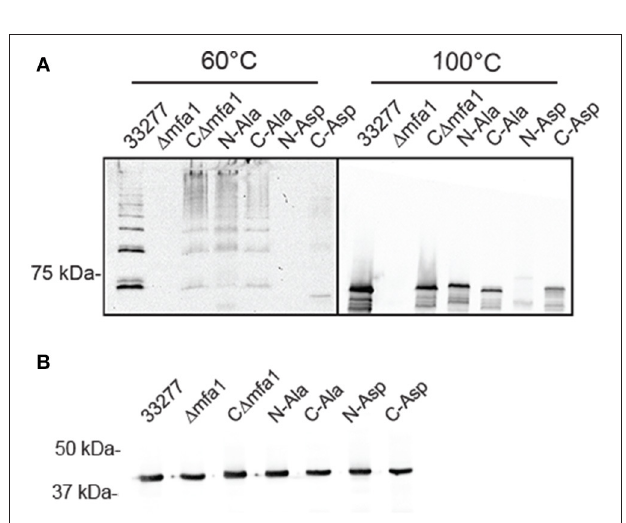
FIGURE 8 | Mfa1 fails to polymerize in P. gingivalis strains expressing substitutions in hydrophobic domains. P. gingivalis strains 33277, 1 mfa1, or 1 mfa1 complemented with pT-COW containing mfa1 wild type allele or the N or C terminal alanine or aspartic acid substitutions were treated at 60 ◦ or 100 ◦ C prior to SDS-PAGE and immunoblotting with antibodies to (A) Mfa1 or (B) FimA. Results are representative of 4 biological